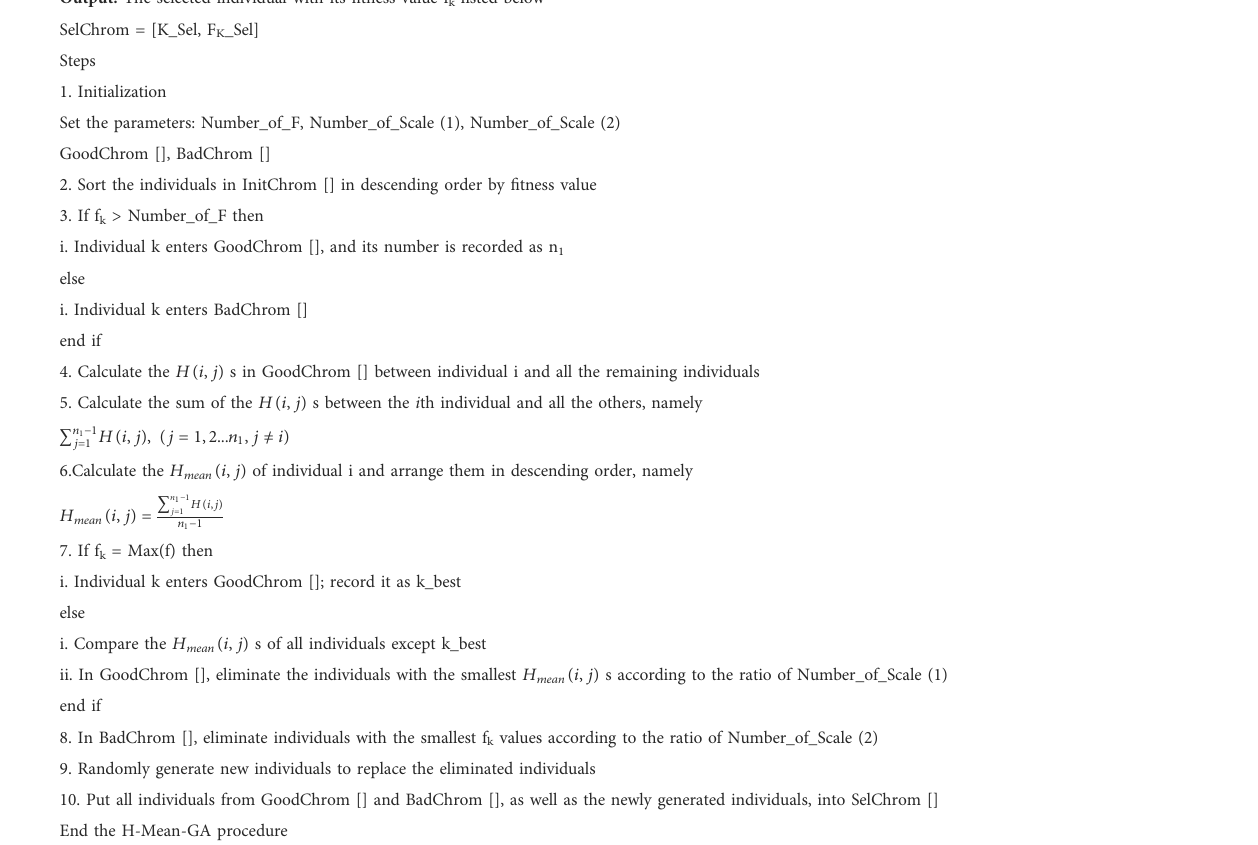
Algorithm 1: H-Mean-based crowding